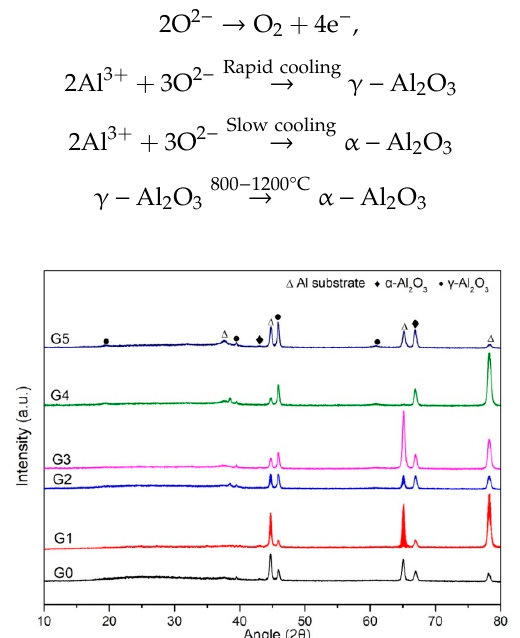
Figure 7. XRD patterns of the coatings with different concentration graphene.